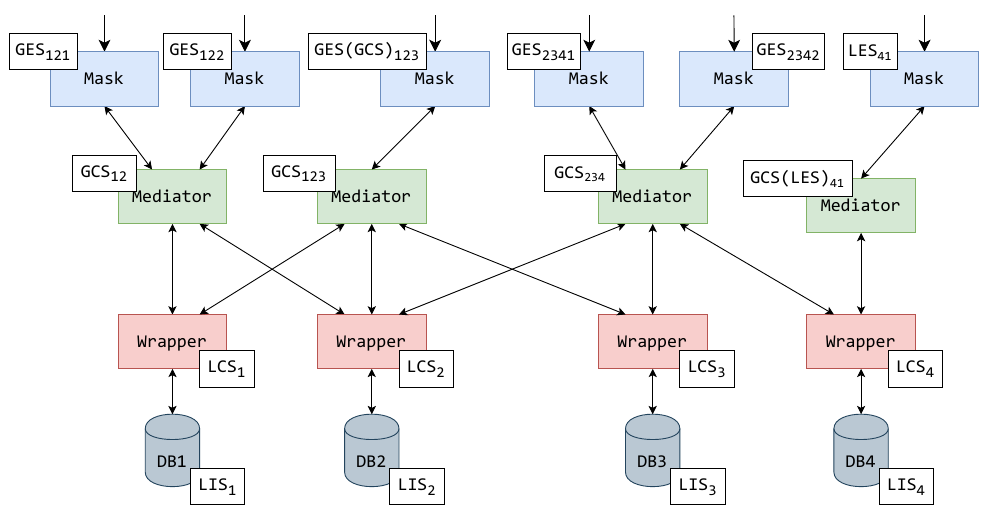
Figure 9. An exemplified assignment of schemas to a MMW